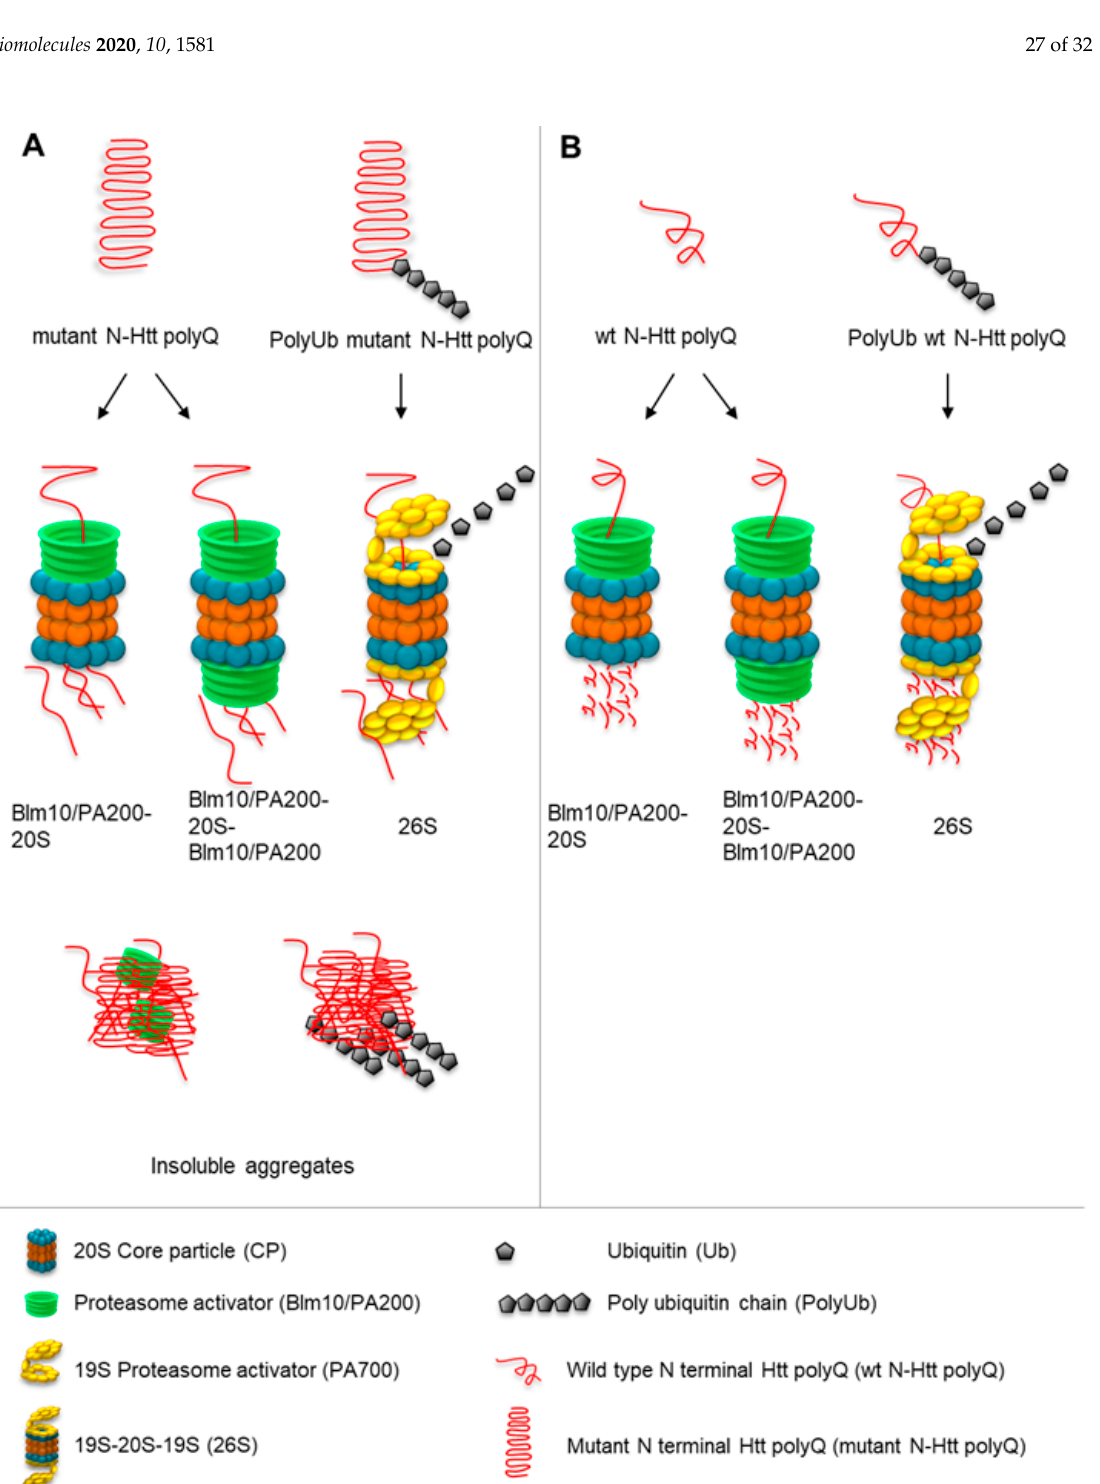
Figure 9. Proposed model of the involvement of Blm10 / PA200 in the proteasomal degradation of mutant ( A ) and wild-type wt ( B ) N-Htt fragments. Soluble wt ( B ) and mutant ( A ) N-Htt polyQ peptides can be degraded by the Blm10 / PA200-20S CP complexes via a ubiquitin-independent pathway. The ubiquitinated Htt is recognized, unfolded, and sent for degradation to the 26S proteasomes. The soluble, non-ubiquitinated N-Htt polyQ peptides are sent to Blm10 / PA200-proteasomes complexes for degradation.